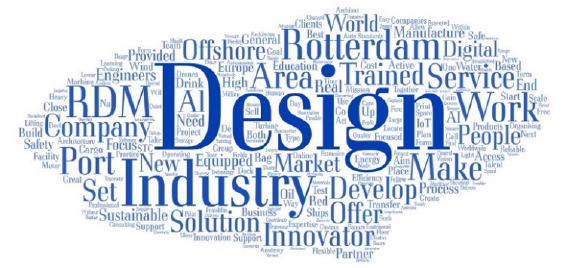
Figure 7. Word cloud derived from RDM company